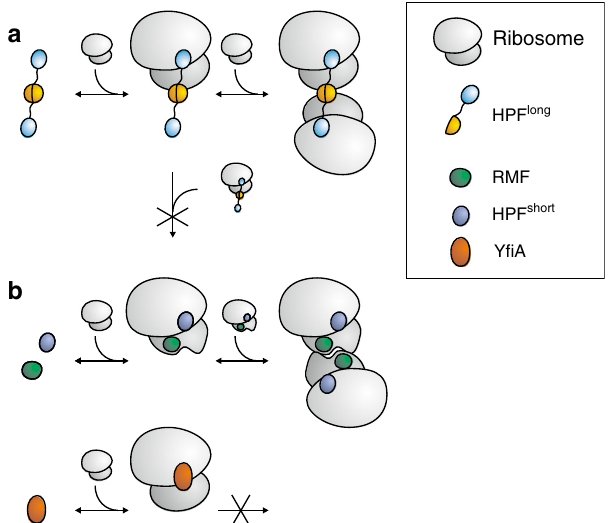
Fig. 7 Schematic of dimerization of ribosomes in L. lactis and E. coli . Because HPF long is a dimer in solution it will collect two ribosomes consecutively ( a ). Prolonged exposure to an excess of HPF long shifts the equilibrium toward monomeric inactive ribosomes. In E. coli , ( b ) each ribosome fi rst collects a copy of HPF short and RMF. The conformational change upon binding of RMF allows the two ribosomes to dimerize. When Y fi A binds at the location of HPF short , RMF can no longer bind and the ribosomes do not